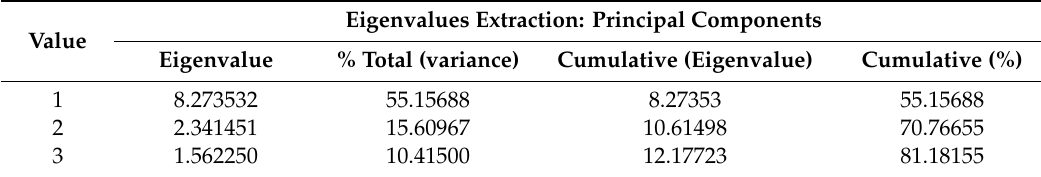
Table 3. Eigenvalues and